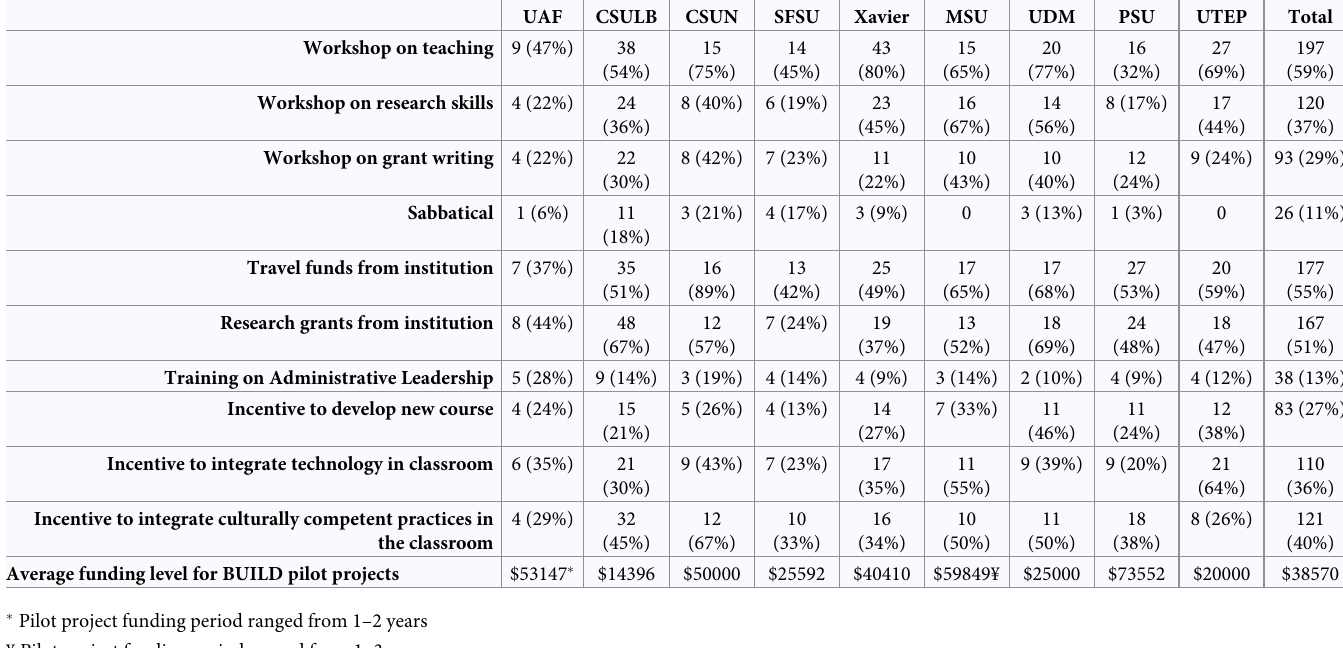
Table 3. The count and proportion of participants at each BUILD site who used a research tool at their institution, HERI Survey 2016–2017.